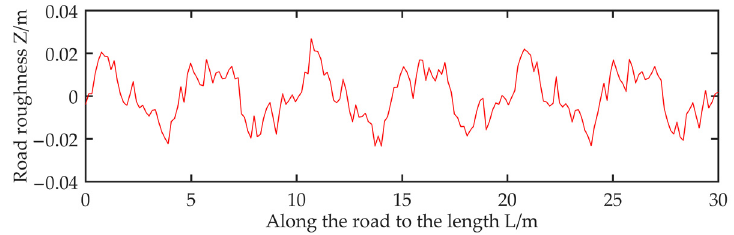
Figure 1. Variation of random unevenness of Class B pavement along the strike.